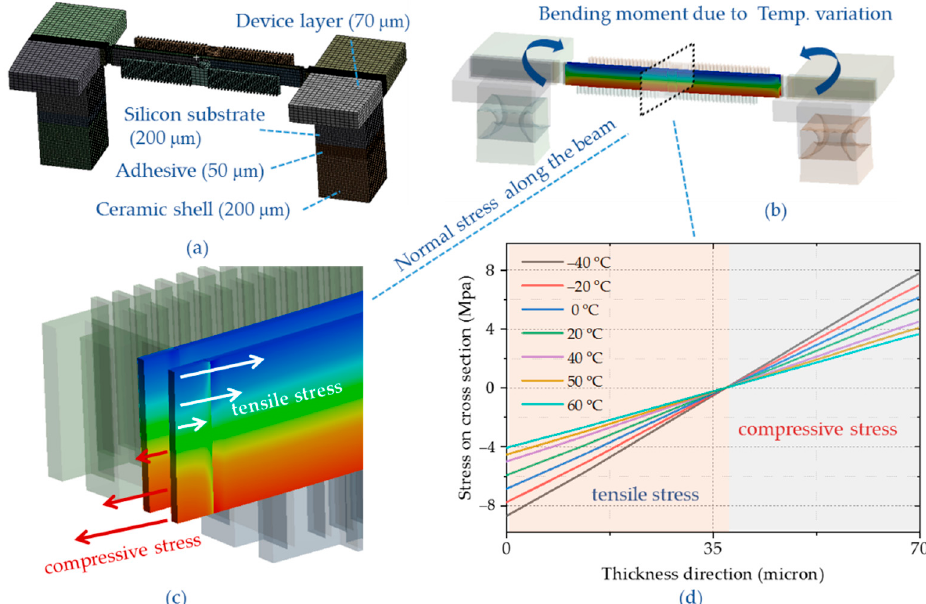
Figure 4. ( a ) The double-clamped resonator model for temperature characteristic; ( b ) Bending moment deformation caused by thermal stress; ( c ) Distribution of axial normal stress on cross-section profile; ( d ) The normal stress distribution along the longitudinal direction of the beam with different temperature.